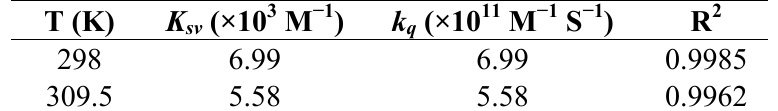
Table 1. Stern-Volmer quenching constants for the interaction between HSA and BZF.